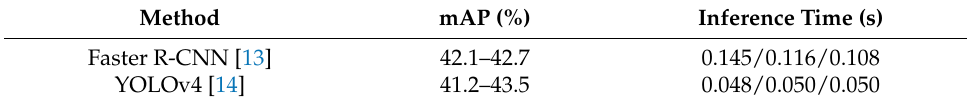
Table 3. Real-time performance of pedestrian detectors.